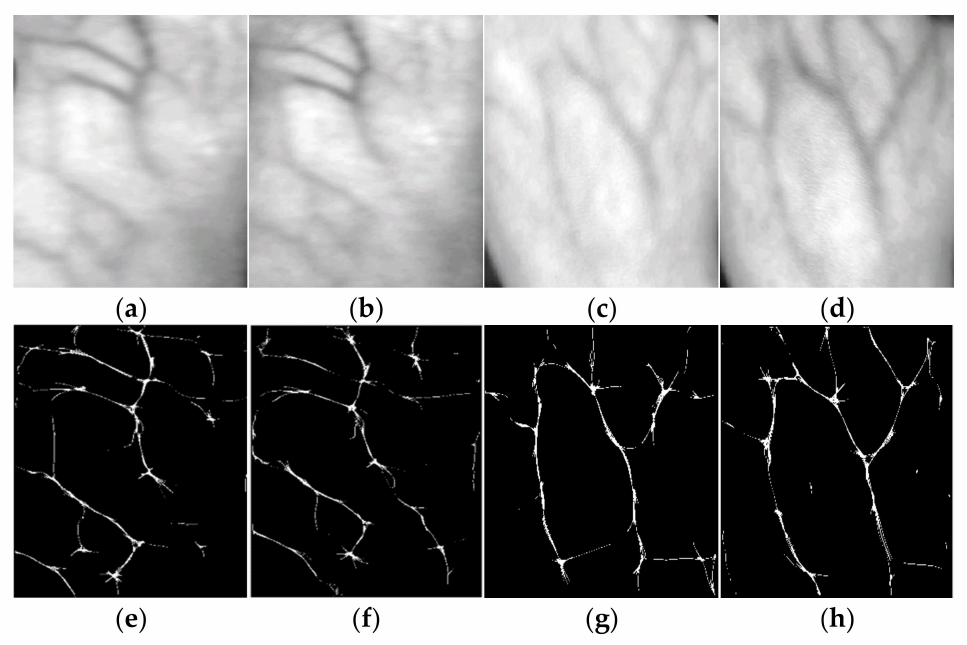
Figure 3. Wrist ( a , b ) and dorsal hand ( c , d ) samples of the same individual, and their Maximum Curvature features ( e , f ) and ( g , h ),